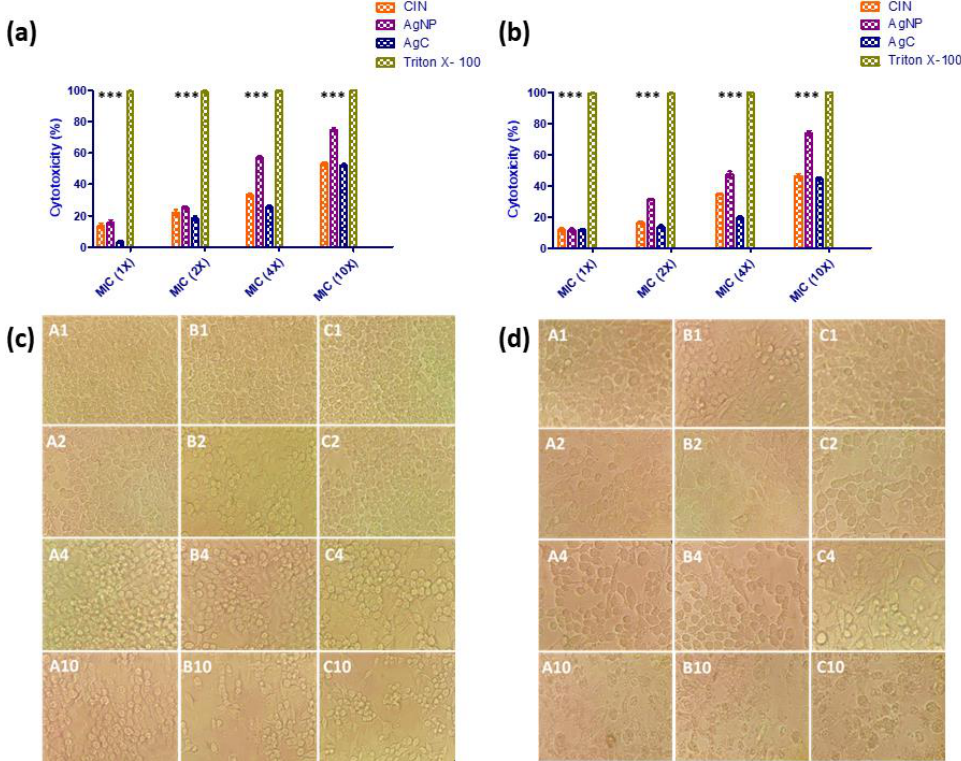
Figure 2. In vitro cytotoxicity of AgC. In vitro cytotoxicity of AgC on RAW 264.7 ( a , c ) and HEp-2 ( b , d ) cell lines treated with different concentrations of cinnamaldehyde (CIN) (A1-1X, A2-2X, A4-4X and A10-10XMIC), AgNPs (B1-1X, B2-2X, B4-4X and B10-10X MIC) and AgC (C1-1X, C2-2X, C4-4X and C10-10X MIC). Figure ( a , b ) denotes % cytotoxicity, while figure ( c , d ) resembles morphological changes such as loss of monolayer, vacuolization of cytoplasm, granulation in corresponding cell lines observed under microscope (40X) at 24 h of incubation. *** indicates statistically significant ( p < 0.001) in comparison to